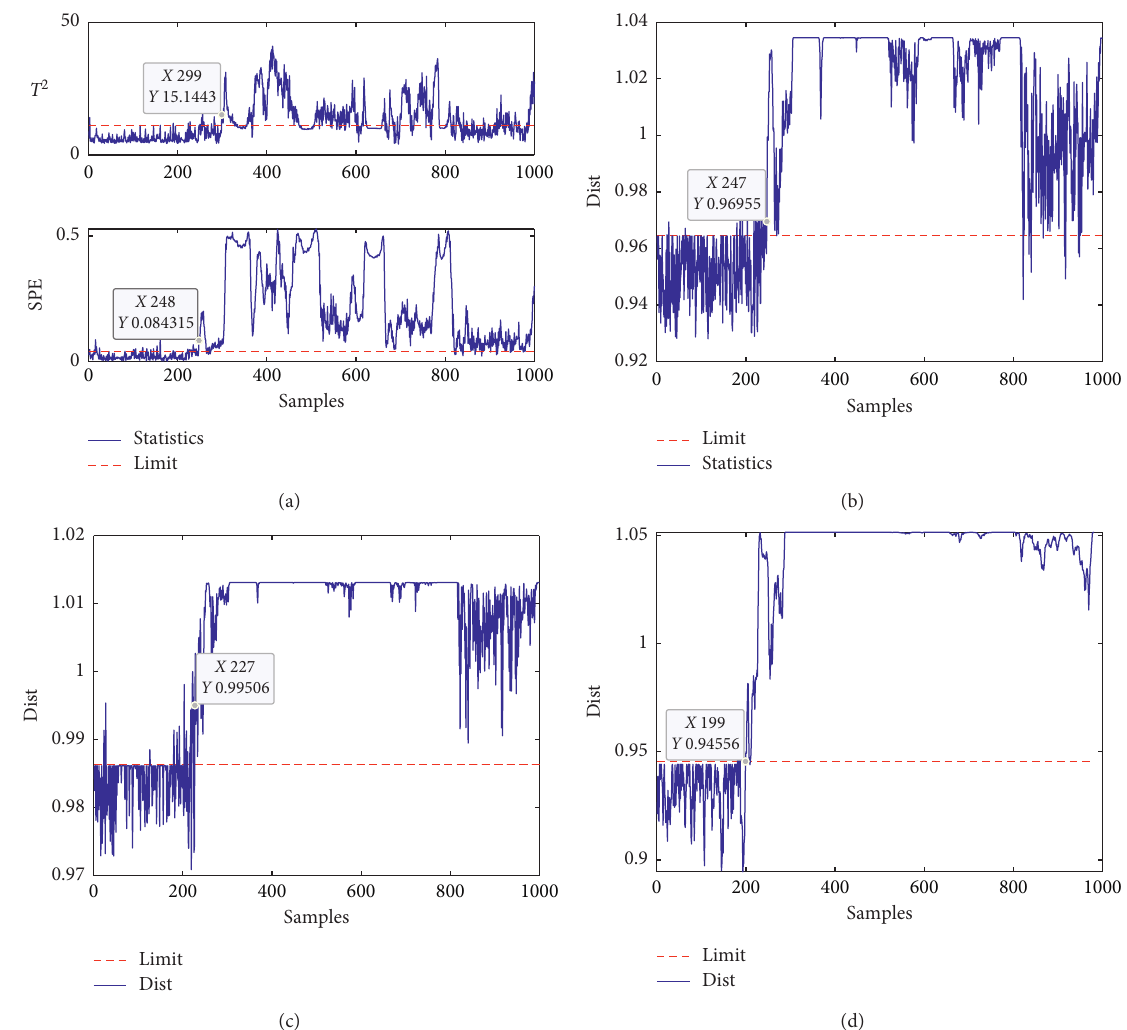
Figure 5: Monitoring results for fault 13 of Mode 3 by (a) KPCA, (b) conventional SVDD, (c) LDR-wSVDD, and (d) SmLRDR-wSVDD.